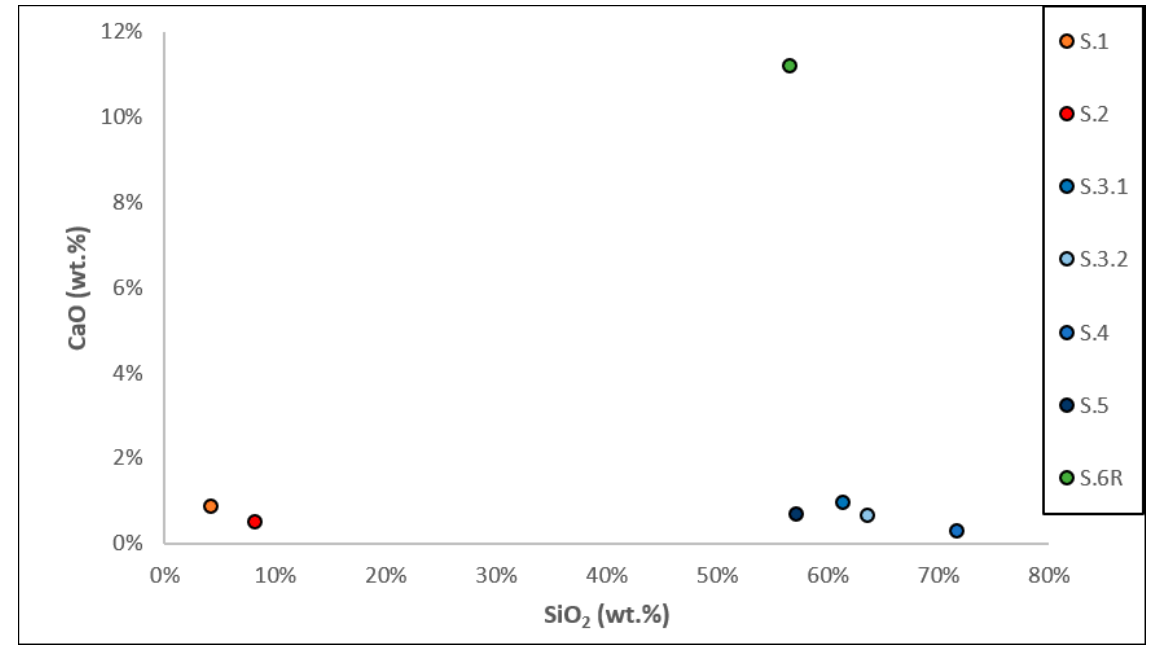
Figure 8. XRF data. Scatter plot SiO 2 -CaO, color coded by sample.